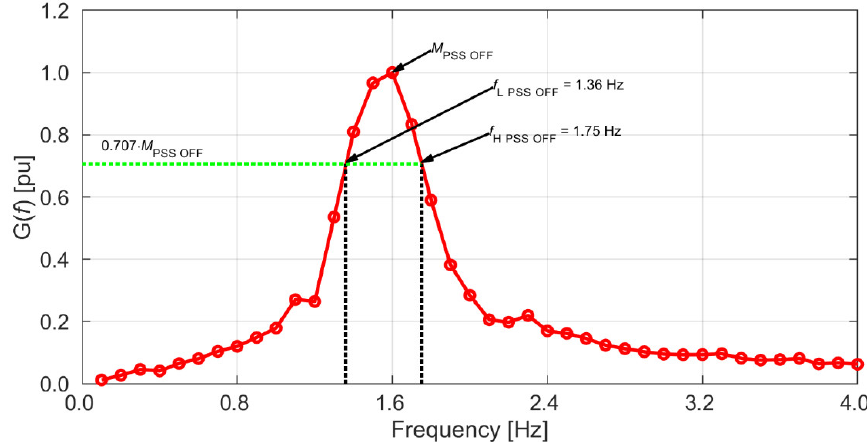
Figure 11. Active power frequency response G PSS OFF ( f ), test conditions: PSS is OFF, P g = 382 MW, Q g = 0 Mvar [39].